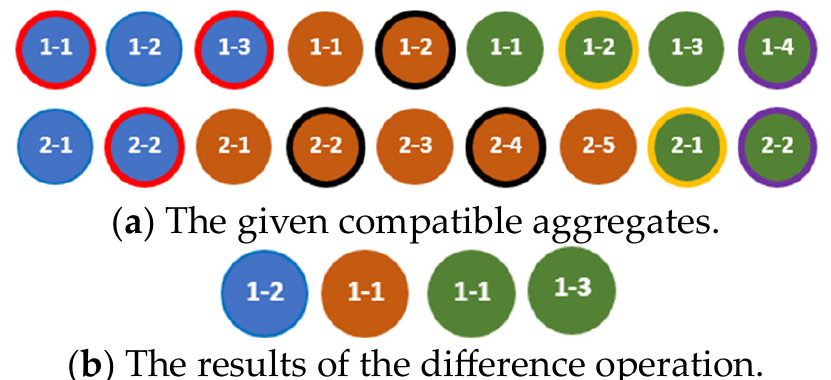
( b ) The results of the di ff erence operation. Figure 10. An example of applying the difference operation to two compatible Figure 10. An example of applying the di ff erence operation to two compatible aggregates.